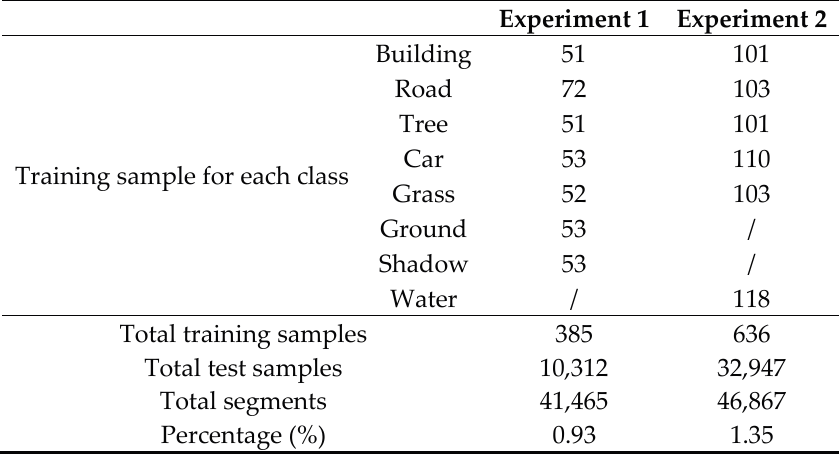
Table 1. Statistics of the training and test